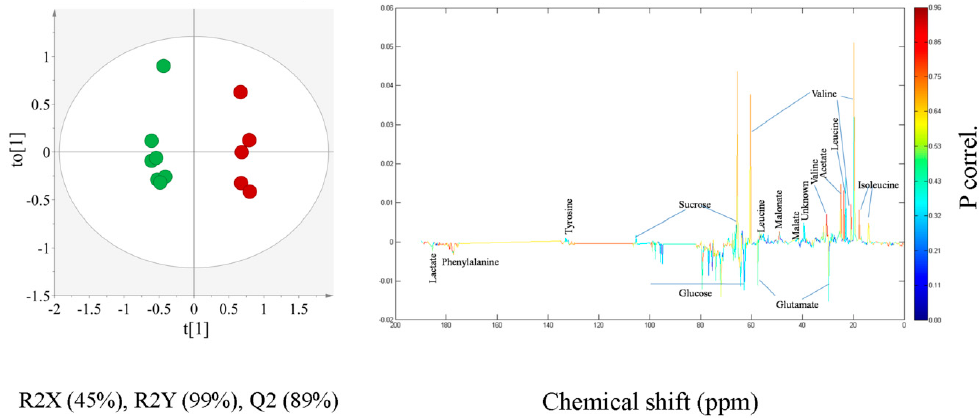
Figure 4. OPLS-DA score scatter plot derived from 13 C-NMR spectra of Chinese red cooking (green circle) and Singapore Kikkoman (red circle) soy sauce and the color-coded loading line plot generated from the OPLS-DA model representing the metabolites responsible for discrimination among Chinese red cooking and Singapore Kikkoman soy sauce.